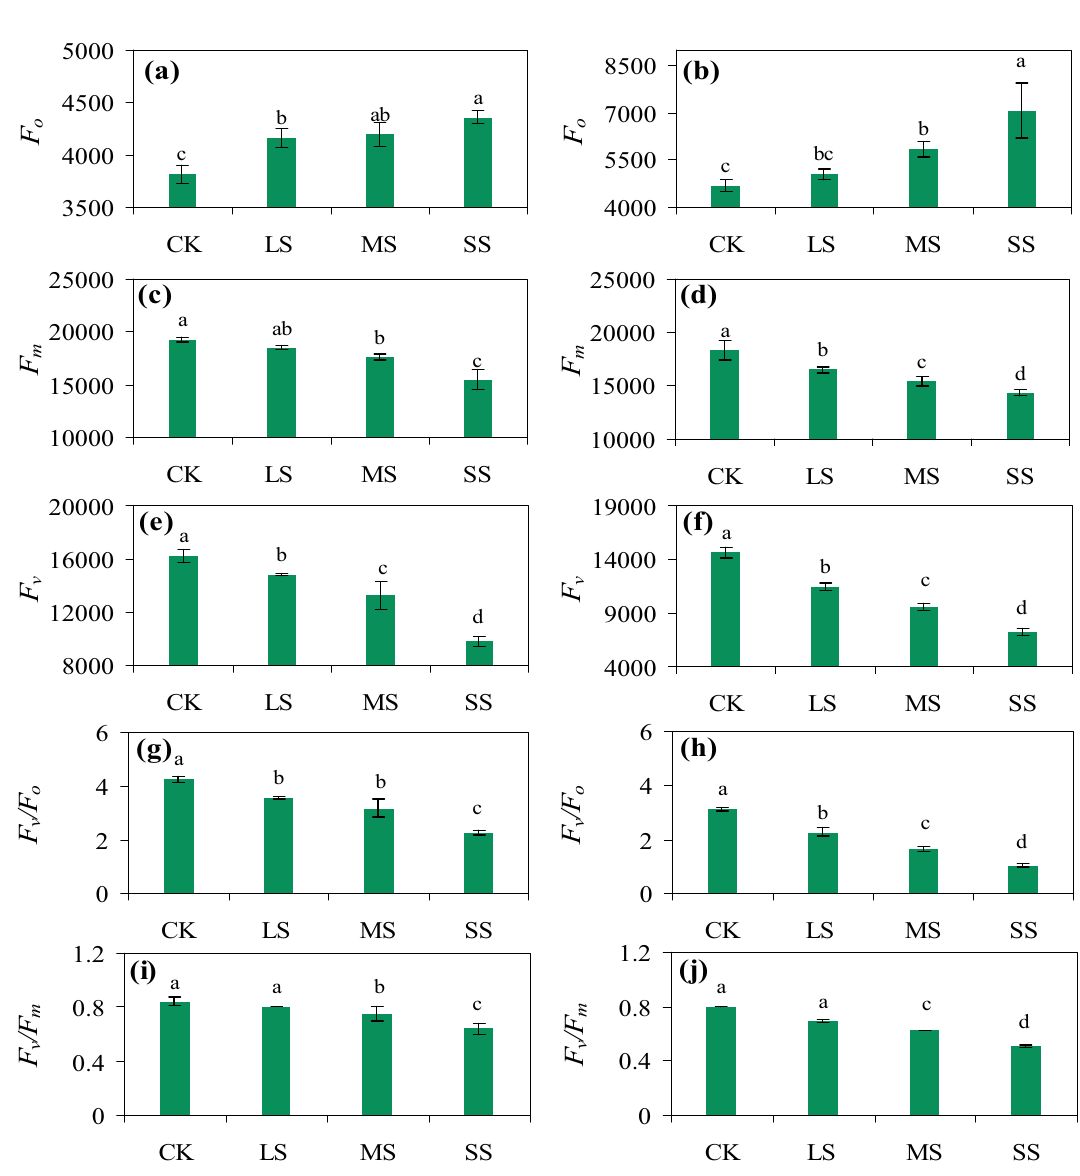
Figure 4. The initial fluorescence value ( F o ), maximum fluorescence value ( F m ), F v / F o and F v / F m under the control treatment (CK), low drought stress (LS), moderate drought stress (MS) and severe drought stress (SS) in 2018 and 2019. ( a , c , e and g ) represent the values in 2018, while ( b , d , f and h ) represent the values in 2019. Different letters above the columns indicate significant differences ( P < 0.05) determined by a Duncan’s test between treatments. The same letters above the error bars indicate no significant difference at P < 0.05.